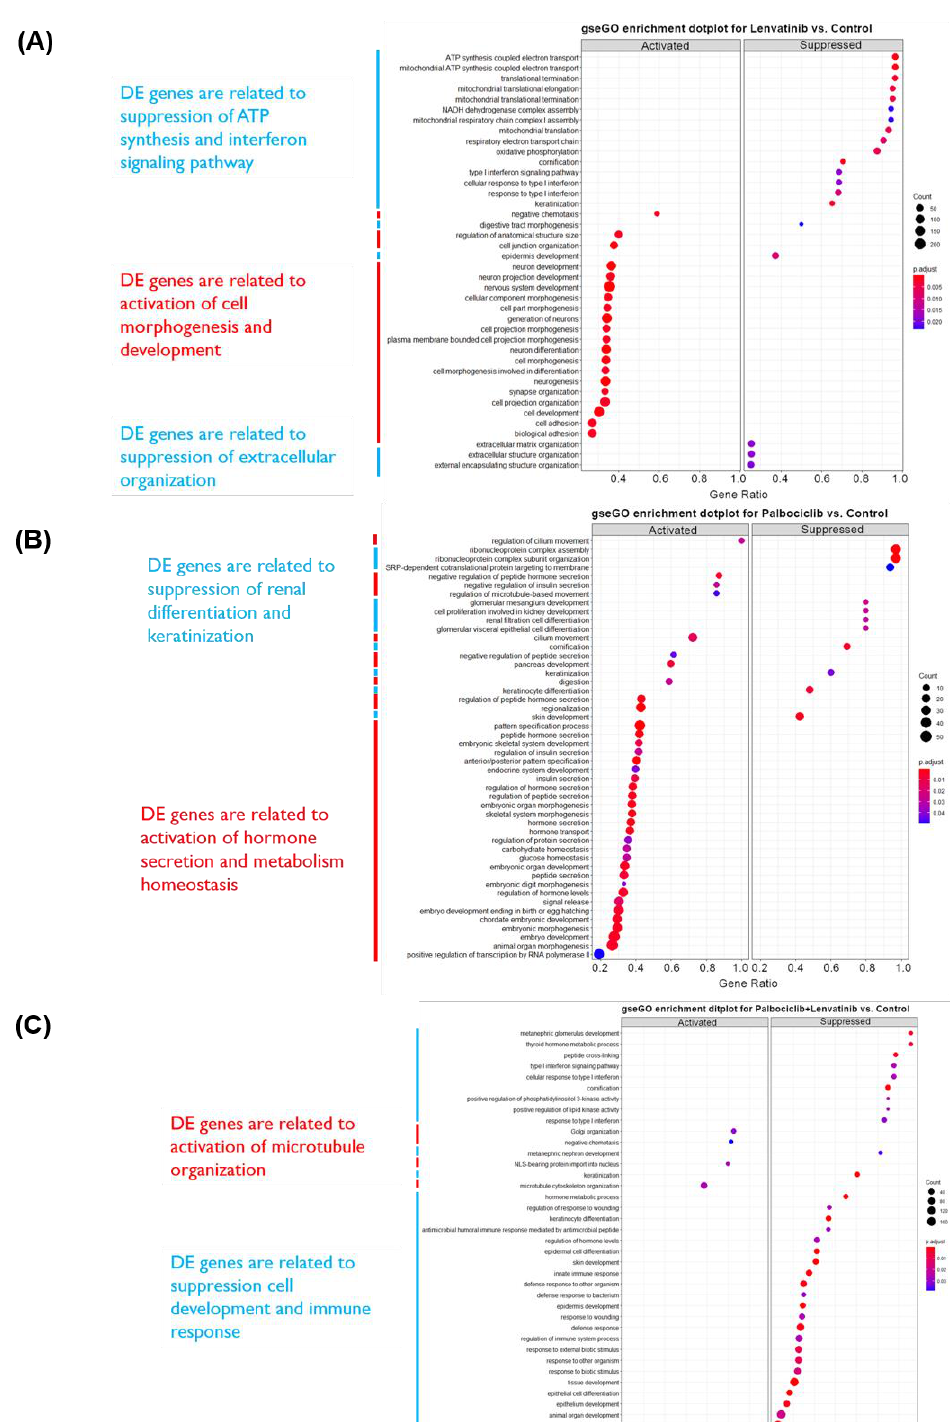
Figure 4. Differentially expressed genes of PDX-mLung treated with different drugs. ( A ) PDX- mLung treated with lenvatinib ( B ) PDX-mLung treated with palbociclib. ( C ) PDX-mLung treated with lenvatinib and palbociclib. DE: differential expression. Functional annotation analyses were performed to establish signaling pathways, biological processes and molecular functions associated with differentially expressed (DE) genes (left-hand side).